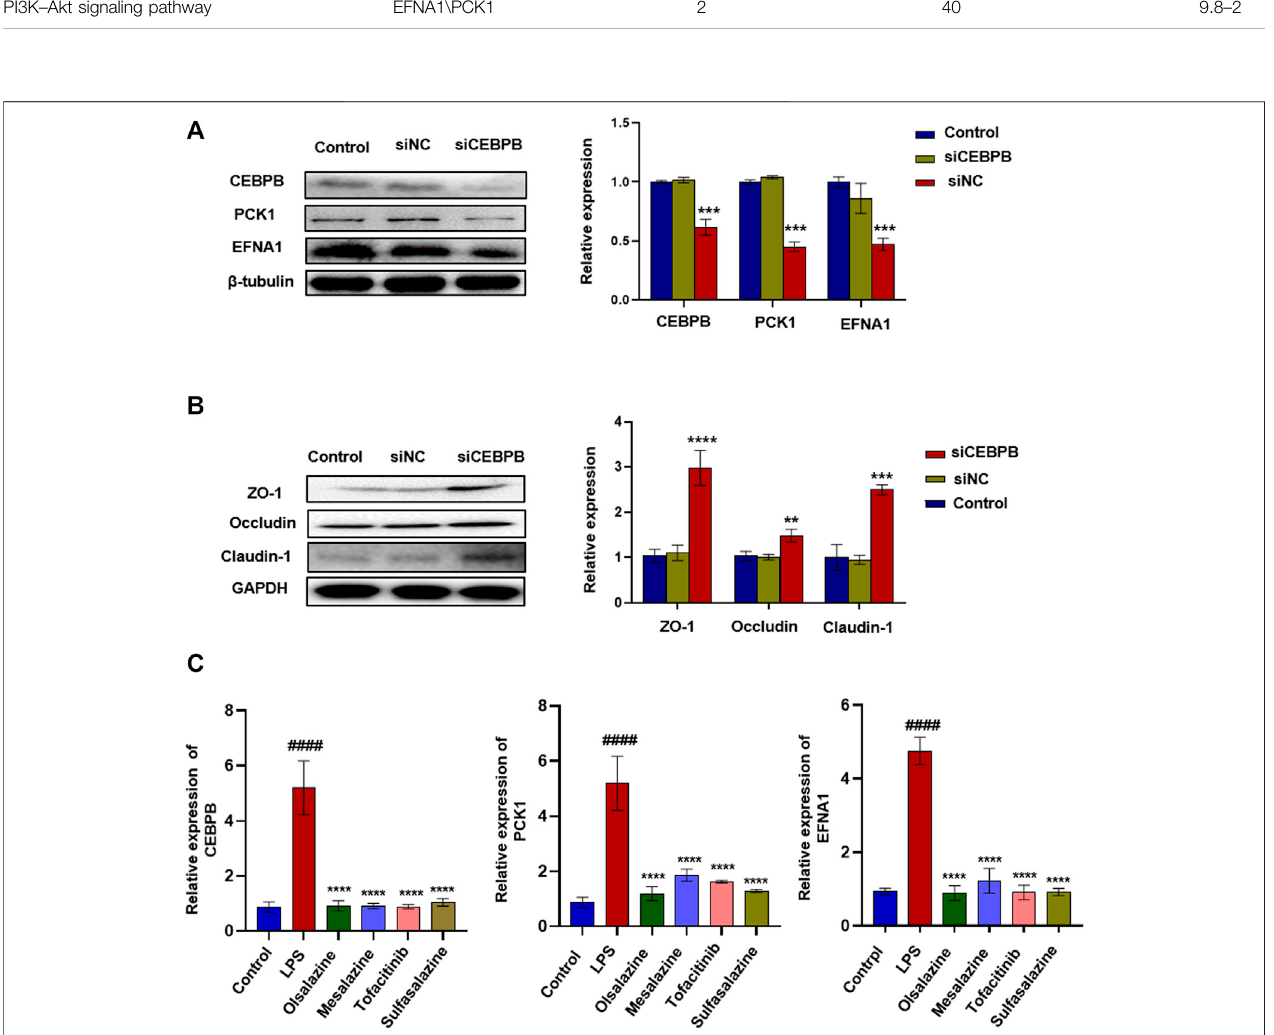
FIGURE 2 | Silencing transcription factor CEBPB signi fi cantly inhibited the expression of PCK1\EFNA1 and increased the expression of intestinal epithelial barrier protein. Theprotein expression ofsuper-enhancer – associated gene PCK1\EFNA1 (A) and intestinal barrier proteins ZO-1, occludin, and claudin-1 (B) after transfection of siCEBPB. Data are presented as the mean ± SD ( n = 3). * p < 0.01 and **p < 0.05 signi fi cantly different from the control group. (C) Inhibitory effect of IBD marketed drugs (olsalazine, mesalazine, tofacitinib, and sulfasalazine) on CEBPB, PCK1, and CEBPB mRNA. Data are presented as the mean ± SD ( n = 3). #### p < 0.001 signi fi cantly different from the control group; *p < 0.1, ***p < 0.001 and ****p < 0.0001, signi fi cantly different from LPS